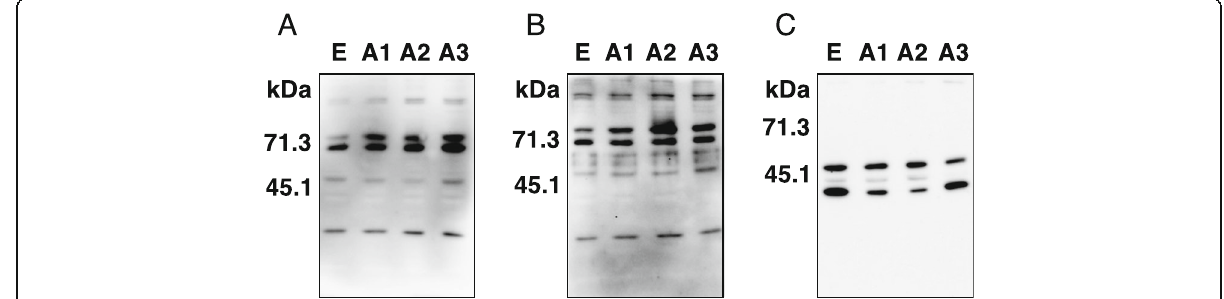
Fig. 2 Detection of three types of AMIGO family molecules by commercially available antibodies. A The same cell lysates as shown in Fig. 1 was used. Lysates were prepared from HepG2 cells transfected with human AMIGO1 (A1), AMIGO2 (A2), AMIGO3 (A3), and an empty vector (E). Immunoblotting with LS-C404504 polyclonal antibody. B Immunoblotting with #36094 polyclonal antibody. C Immunoblotting with HPA054004 polyclonal